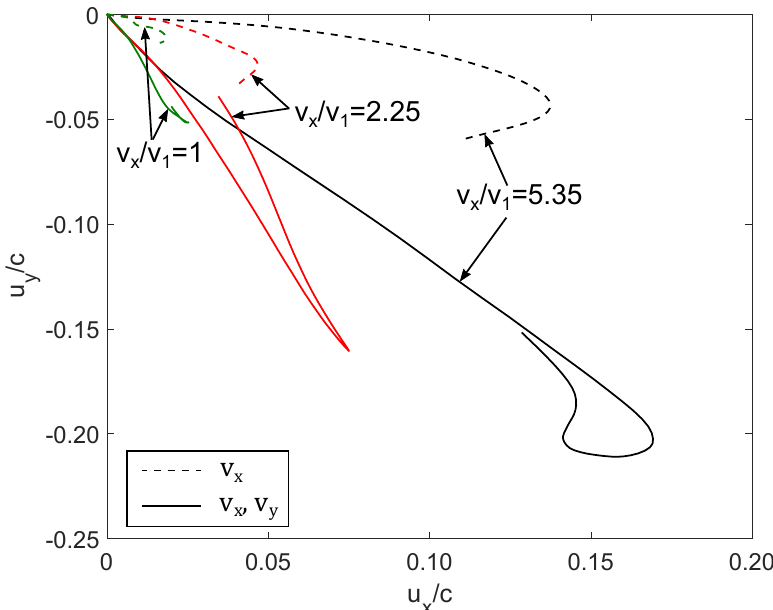
Figure 12. Normalized translation of centre of rotation of blade’s profile at r / R blade = 0.99 radial location, for the different velocities of the killer whale at x -direction, considering one-directional and two-directional velocity of the sea animal; v y = 1 m/s for each case.